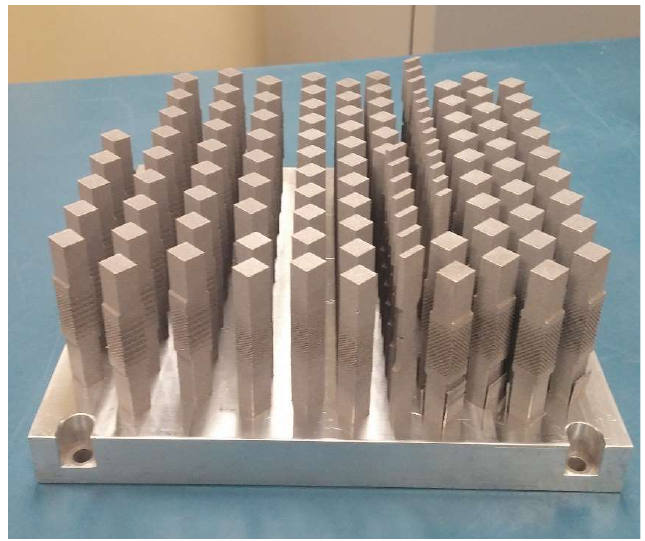
Figure 4 . Printed specimens on the build plate. Figure 4. Printed specimens on the build